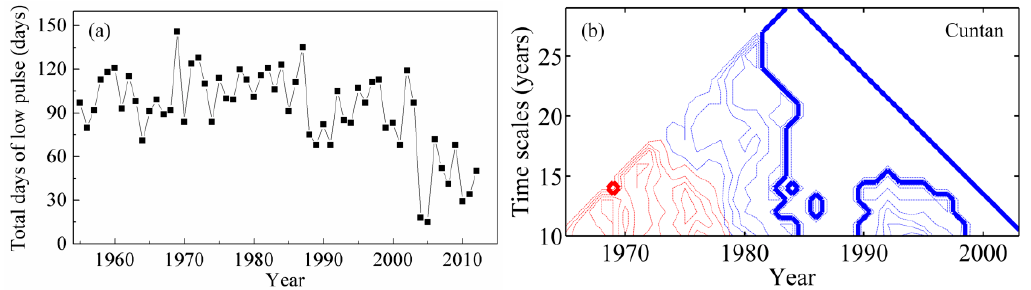
Figure 4. Changes in total days of low pulses at the Cuntan station: ( a ) annual values; ( b ) abrupt behaviors.